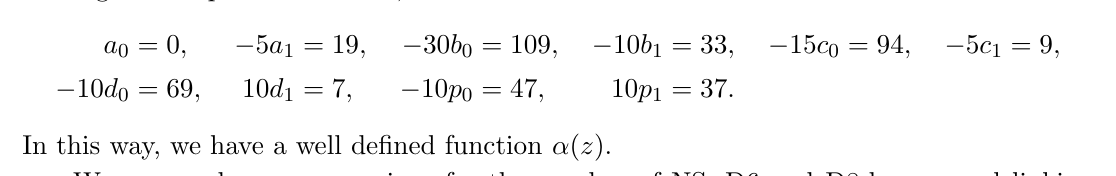
Figure 4. The Hanany-Witten set-up corresponding to the generic (cid:12)eld theory studied here. Solving these equations we